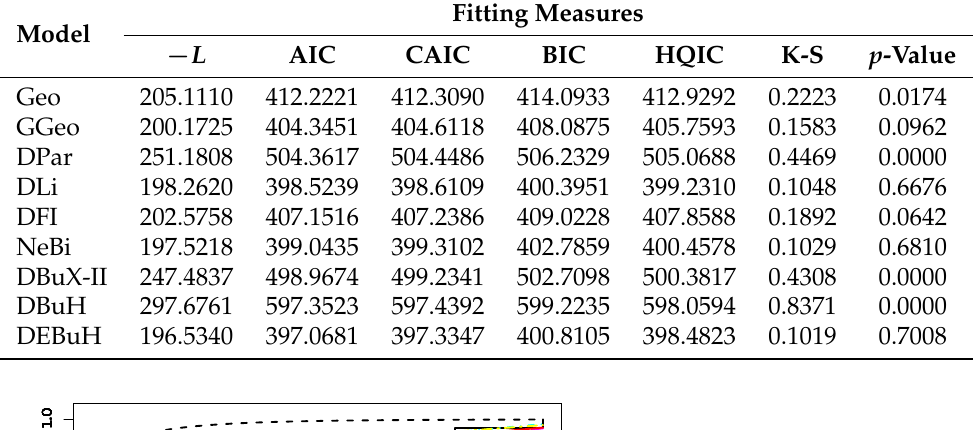
Table 10. Fitting measures of the DEBuH model and other discrete models for data set II. Model